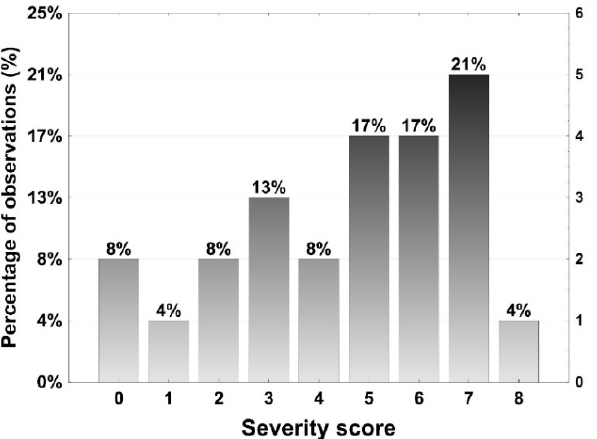
Figure 3. Histogram of severity of COVID-19 illness with participants who were infected, according to the number of symptoms.